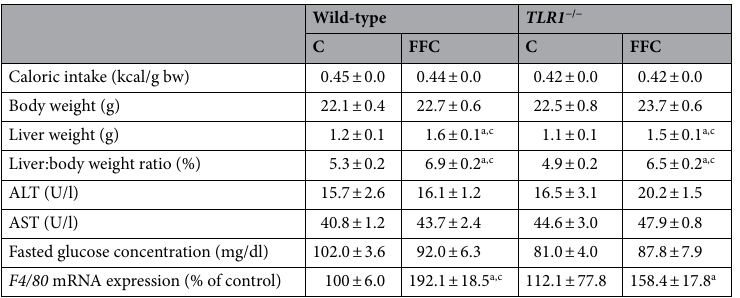
Table 2. Effect of deletion of TLR1 on caloric intake, body- and liver weight and liver damage in FFC-fed mice. Data are shown as means ± SEM, n = 5–6, a p ≤ 0.05 compared to C-fed wild-type mice, c p ≤ 0.05 compared to C-fed TLR1 −/− mice. ALT alanine aminotransferase, AST aspartate aminotransferase, C control diet, FFC fat-, fructose-, and cholesterol-rich diet, TLR toll-like